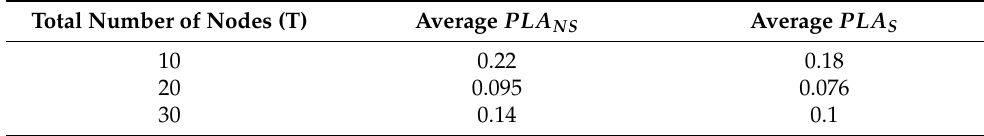
Table 5. Average probability of linkability (PLA) of the source